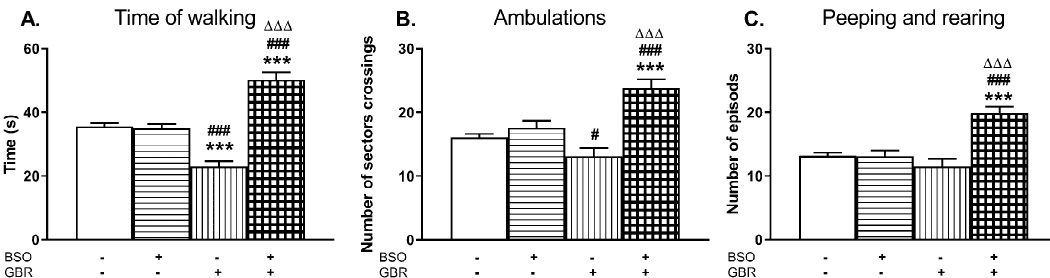
Figure 8. The e ff ects of chronic administration of BSO and GBR 12909, alone or in combination, during the early postnatal life on the exploratory behavior in the open field measured in the adulthood; ( A ) time of walking, ( B ) ambulation, ( C ) peeping, and rearing. Statistical analysis was performed using a two-way ANOVA; symbols indicate significance of di ff erences according to the Newman–Keuls post-hoc test, *** p < 0.001, vs. control; # p < 0.05, ### p < 0.001 vs. BSO-; and ∆∆∆ p < 0.001 vs. GBR 12909-treated group.